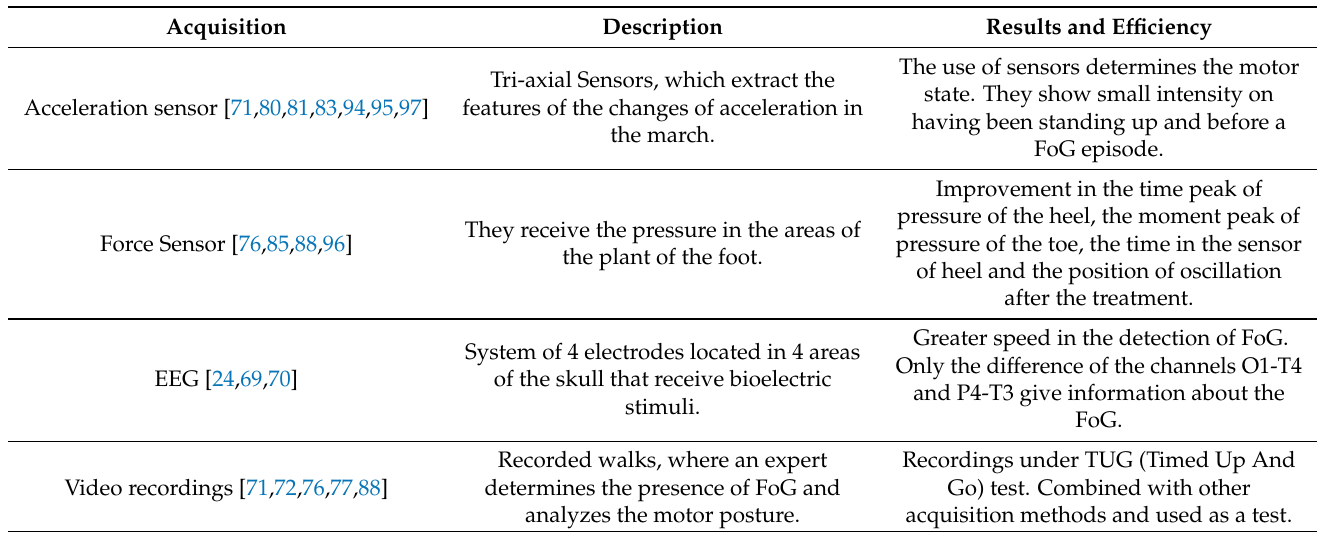
Table 1. Description of devices developed until today to help patients with episodes of FoG based in the acquisition type.